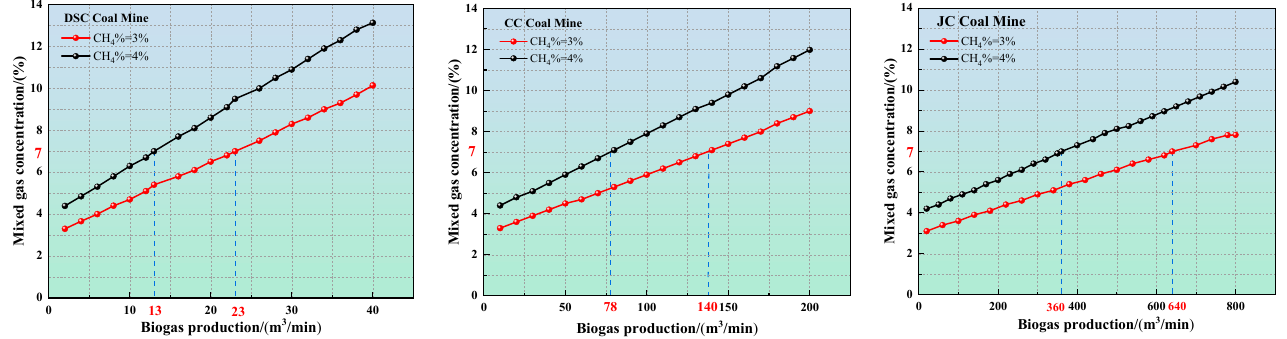
Figure 7. The amount of biogas production to meet required by the co-production system. Table 3. Parameters of the co-production system for power generation in coal Table 2. Lean methane emissions estimation for coal mines in three regions .